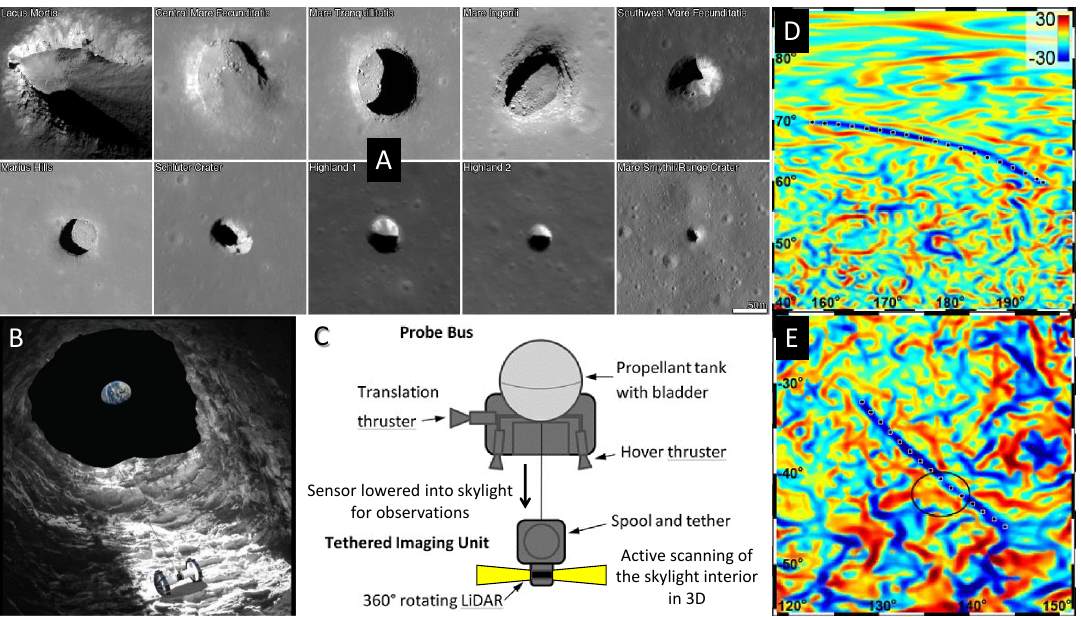
Figure 9. New views of lunar magmatic structures. ( A ) Lava tube skylights located in different parts of the Moon, enabled by high spatial resolution observations (Source: [184]) . ( B , C ) Mission concepts for the exploration of lava tube skylights (Source: [188], modified from [189]) . ( D , E ) Linear gravity anomalies (LGAs) of large spatial extent (several hundred km) have been interpreted to be ancient magmatic Intrusions (Source: [191])